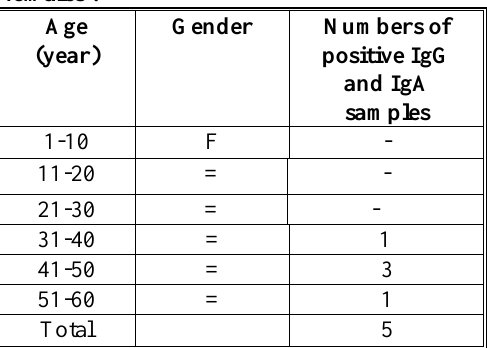
Table (6 ) Age distribution of anti H.pylori IgG and IgA positive serum samples in females .